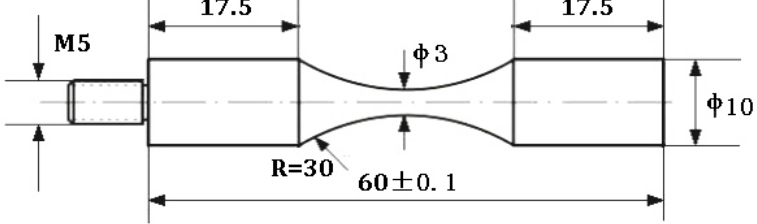
Figure 1. Dimension of the fatigue specimen (All dimensions are in mm).